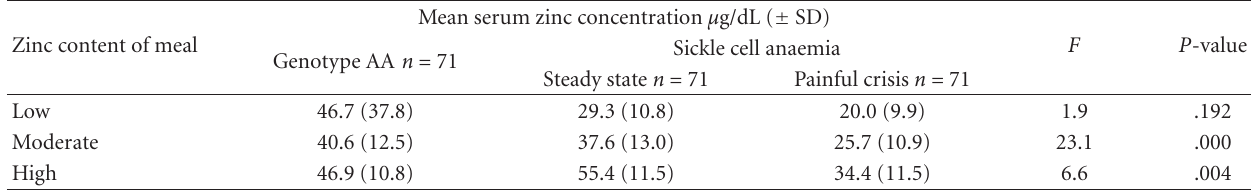
Table 3: Relationship between zinc content of last meal consumed before taking blood and mean serum zinc